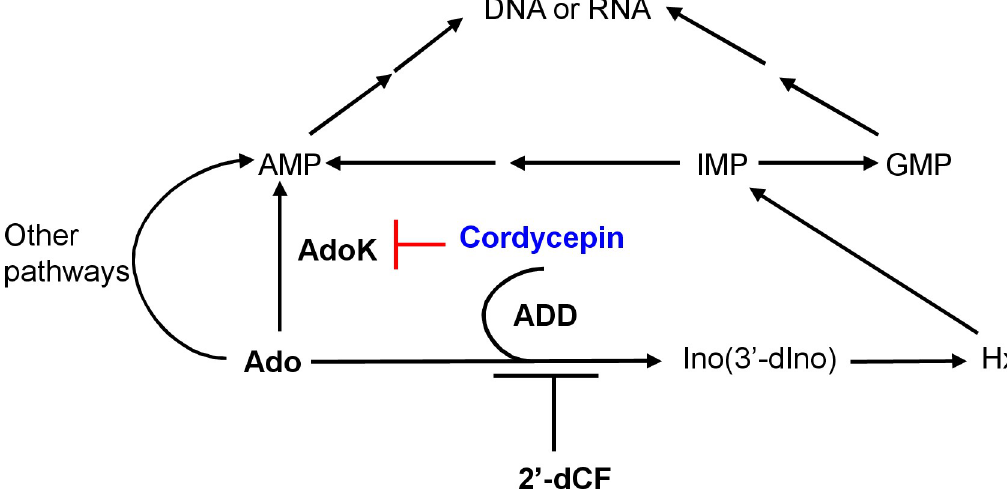
Fig 8. Metabolic pathways of Ado in M . tuberculosis and mycobactericidal mechanism of cordycepin. Ado is converted into AMP by adenosine kinase (AdoK) or inosine (Ino) by adenosine deaminase (ADD) in M . tuberculosis . Cordycepin targets AdoK to form a lethal intermediate structure. Deoxycoformycin (2 0 -dCF) inhibits the activity of ADD to enhance the mycobactericidal role of cordycepin.